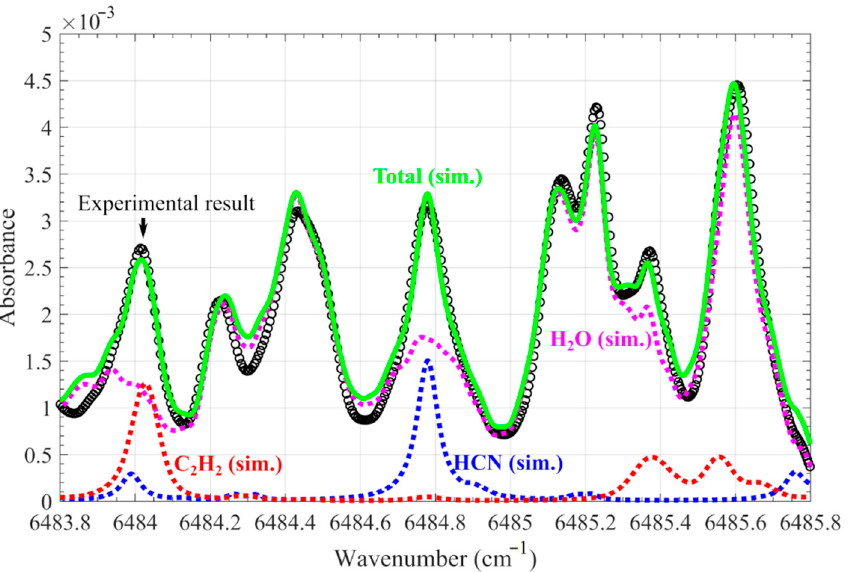
Figure 7. The absorbance spectrum obtained in the plume 5 mm above burning nylon 66 strips in the hot flue gas environment (F7), at 1790 K with a residence time of 20 s (black scattering circle) and the fitted one (green solid line), reflects the absorbance spectrum of 11% H 2 O at 1180 K obtained from our database (magenta dot line), along with the 820 ppm HCN (blue dot line) and 1170 ppm C 2 H 2 (red dot line) using the HITRAN2016 database.